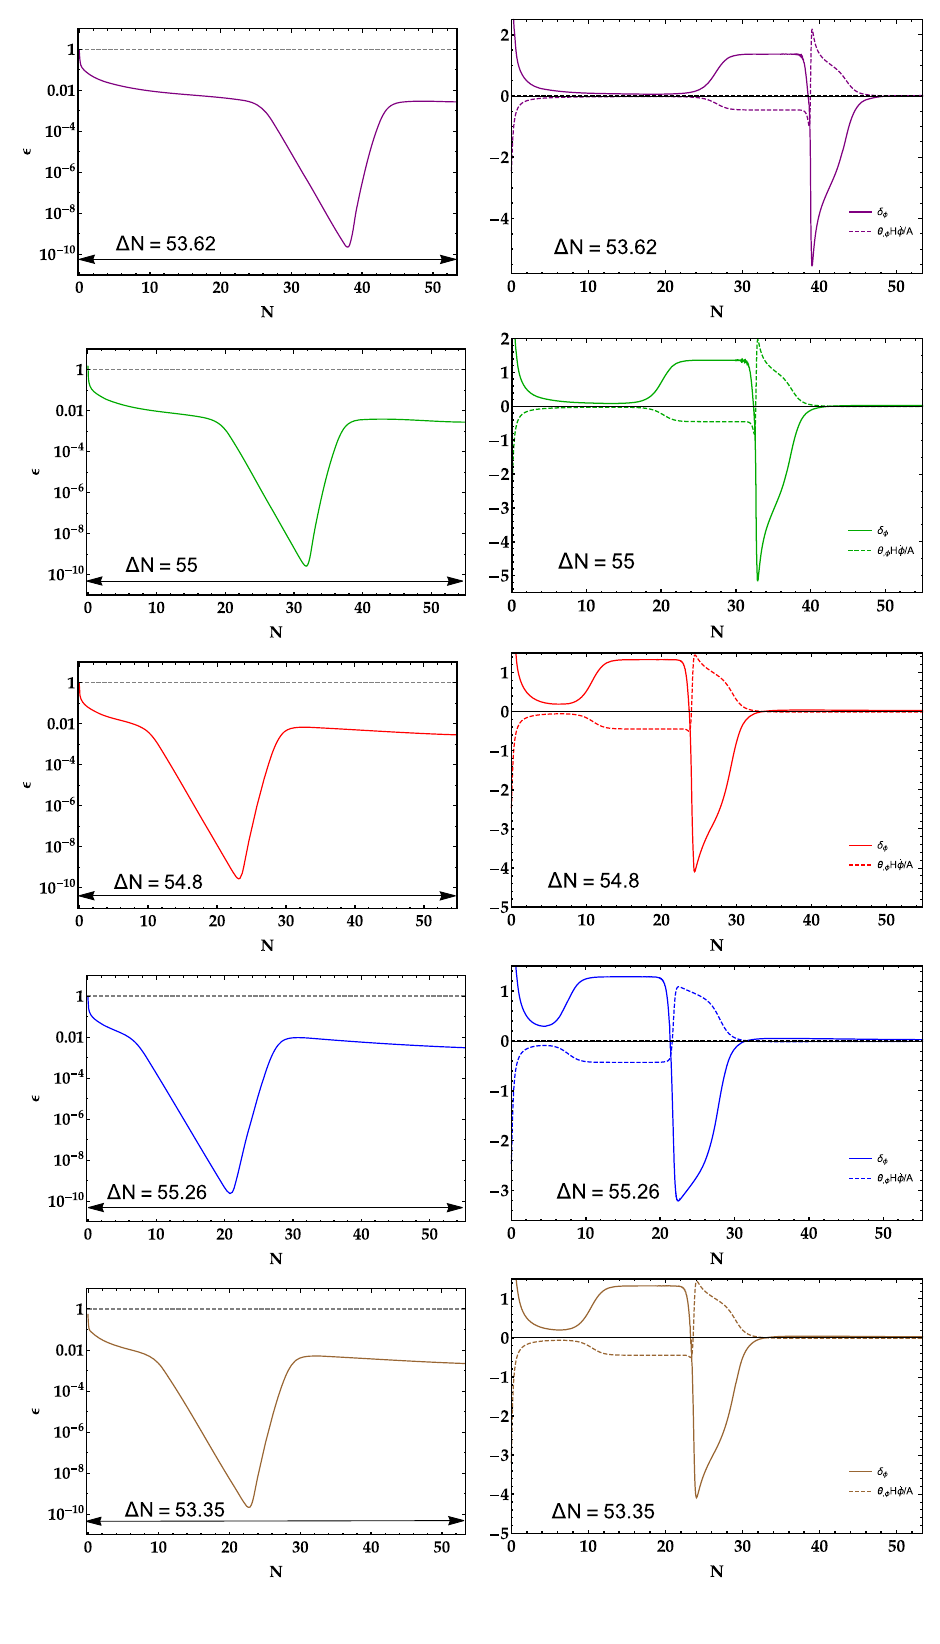
Fig. 2 (left) Evolution of the first slow-roll parameter ε , (right) the second slow-roll parameter δ φ , and θ ,φ H ˙ φ/ A with respect to the e -fold number N for Case A (purple line), Case B (green line), Case C (red line), Case D (blue line), and Case F (brown